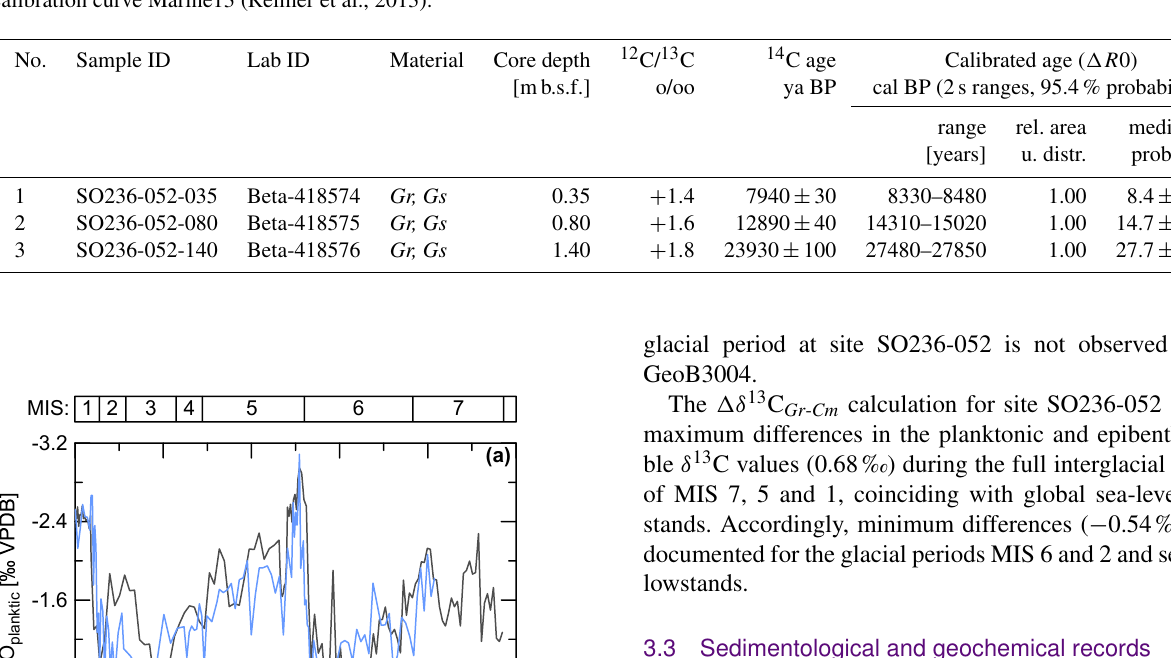
Table 1. Accelerator mass spectrometry (AMS) radiocarbon dating results based on mixed surface-dwelling planktonic foraminifera ( Gr = Globigerinoides ruber , white; Gs = Globigerinoides sacculifer ) from 35, 80 and 140cm of sediment depth in core SO236-052-4. Conven- tional radiocarbon ages were calibrated using the radiocarbon calibration program CALIB (version 7.0.4; Stuiver and Reimer, 1993) and the calibration curve Marine13 (Reimer et al., 2013).